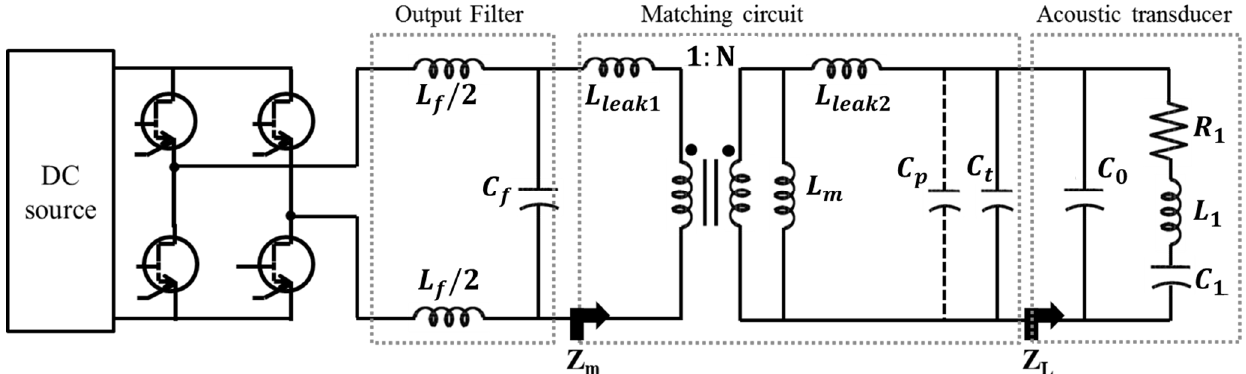
Figure 2. The proposed sonar transmitter circuit diagram with the equivalent circuit model of the acoustic transducer.